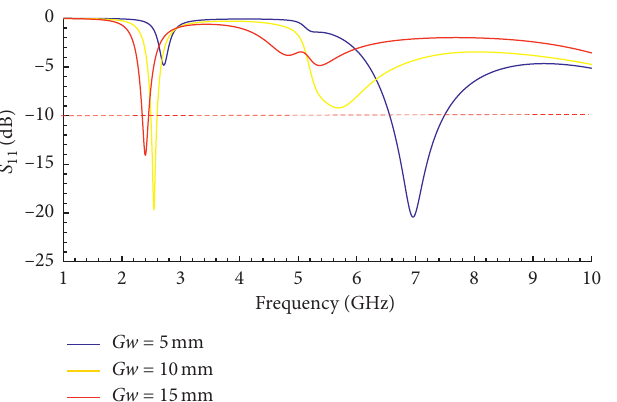
Figure 21: S MPA.